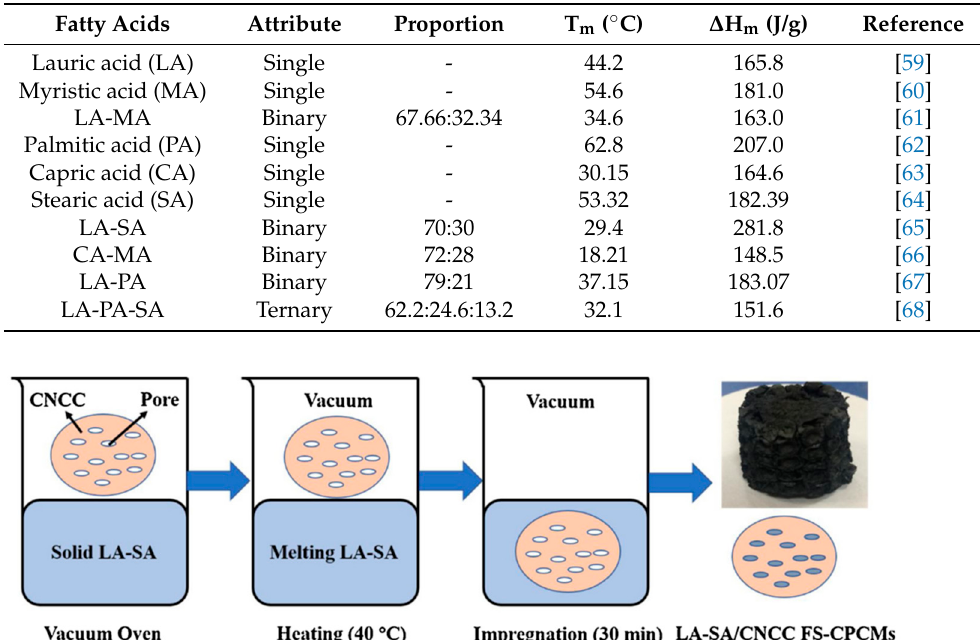
Table 3. Phase change properties of different fatty acids and their complexes.